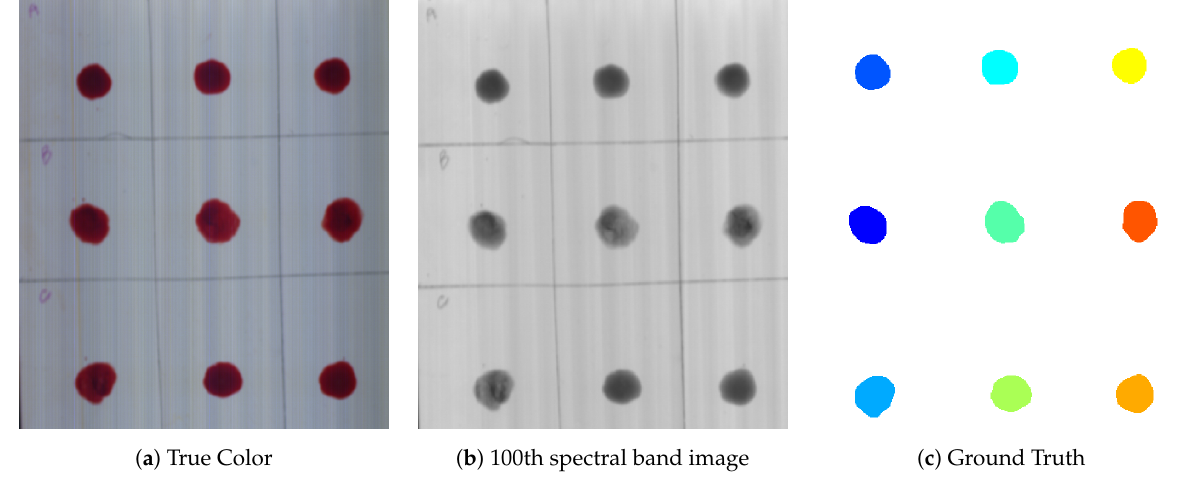
Figure 1. Blood sample deposited on a wall